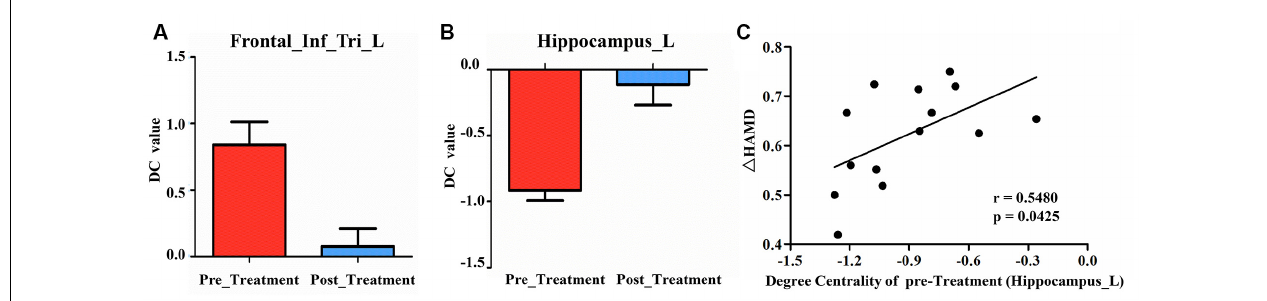
FIGURE 6 | (A) Post-treatment, adolescents exhibited decreased DC in the triangular part of the left inferior frontal gyrus (Frontal_Inf_Tri_L). (B) Post-treatment, adolescents exhibited increased DC in the left hippocampus (Hippocampus_L). (C) Our correlation analysis showed that (cid:52) HAMD was positively correlated with the DC value of Hippocampus_L at